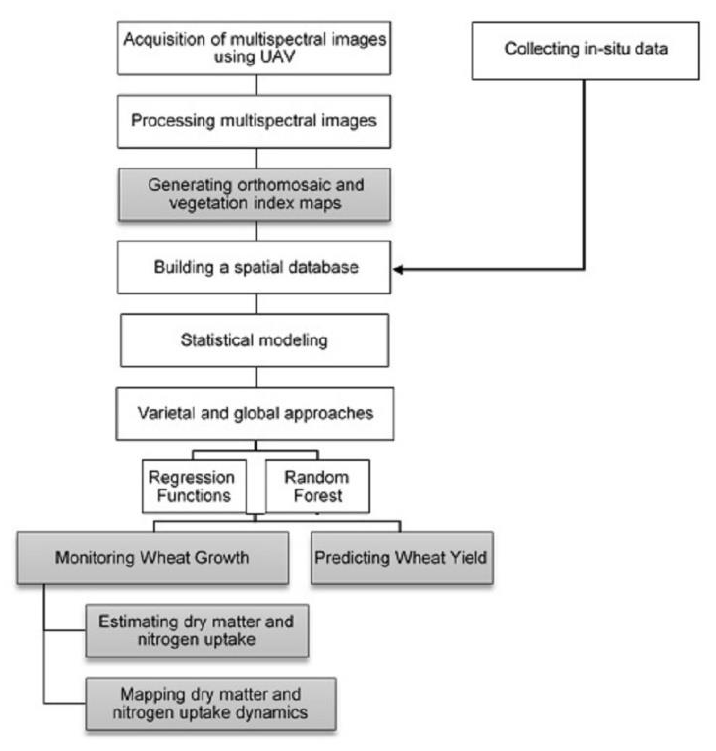
Figure 1. The general methodology used throughout this study.